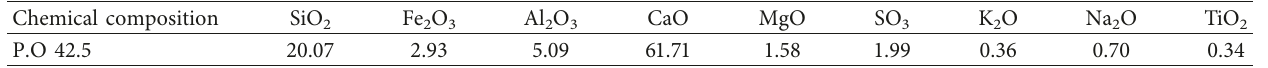
Table 1: Chemical composition of cement (%).